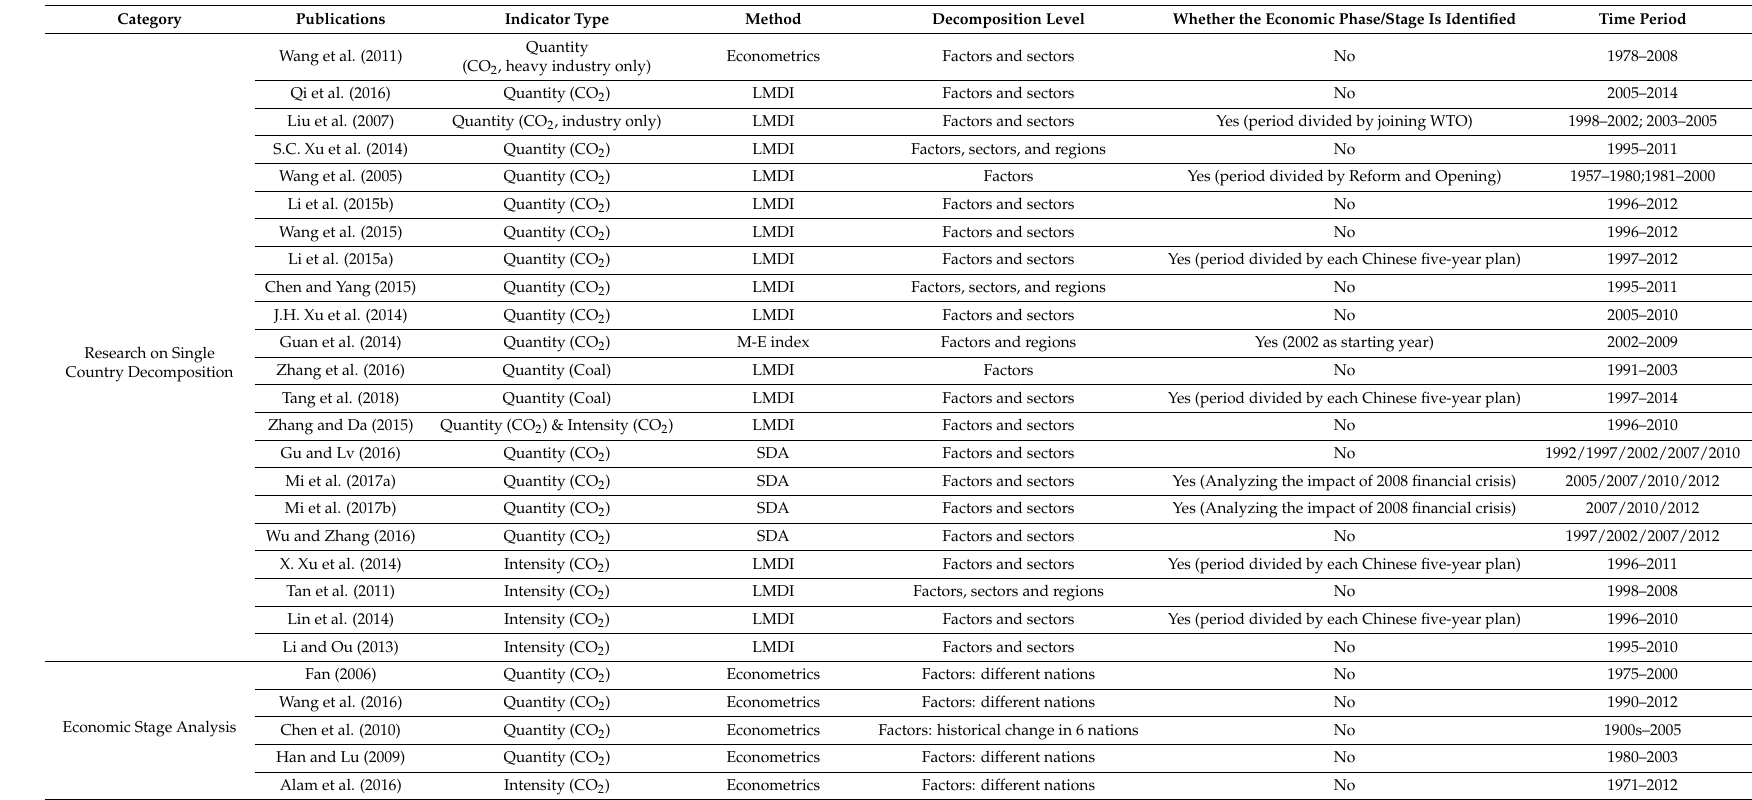
Table 1. Literature Review on Emission Pathway Analysis